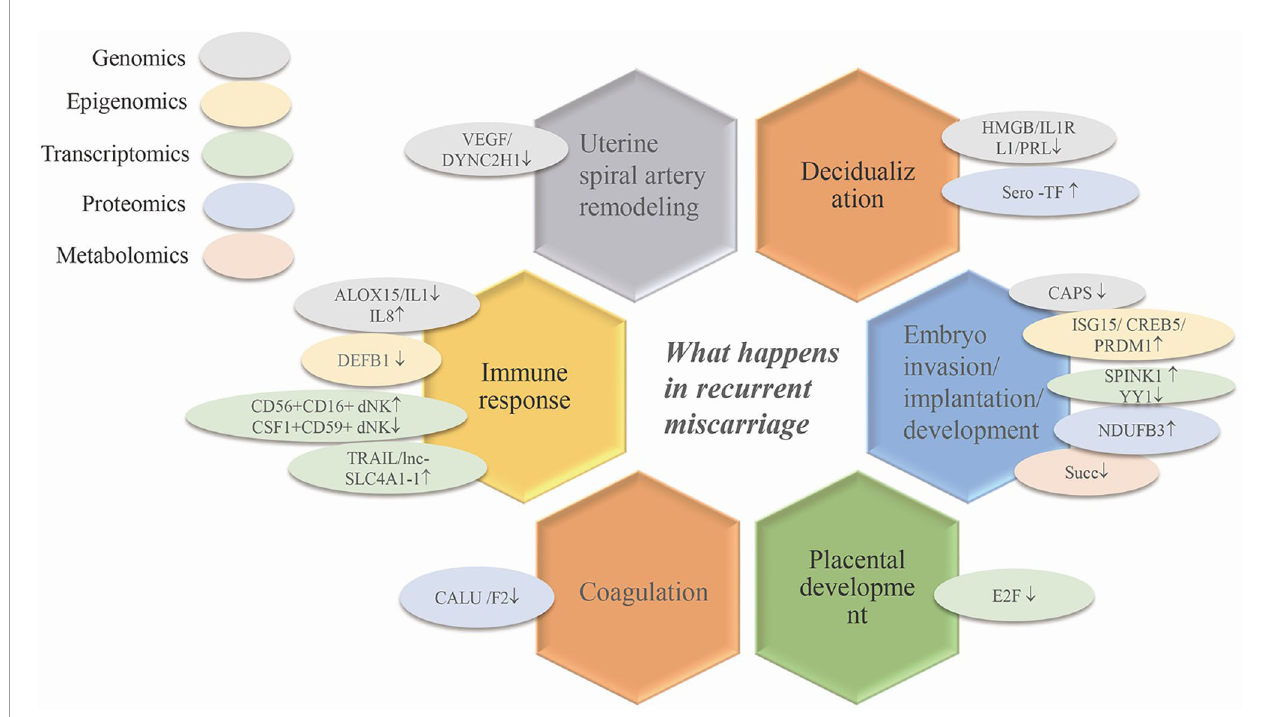
FIGURE 2 | The application of omics techniques in recurrent miscarriage. Ovals of different colors represent different omics studies. VEGF, vascular endothelial growth factor; HMGB, high mobility group box; IL1RL1, interleukin 1 receptor-like 1; PRL, prolactin; ISG15, interferon stimulated gene 15; SPINK1, serine peptidase inhibitor Kazal-type 1; CREB5, cAMP responsive element binding protein5; CAPS, calcyphsine; PRDM1, positive regulatory domain 1; YY1, yin and yang 1 transcription factor; NDUFB3, NADH dehydrogenase (ubiquinone) 1 beta subcomplex 3; E2F, one transcription factor family; IL1, interleukin 1; IL8, IL1, interleukin 1; CD56+CD16+dNK/CSF1+CD59+dNK, transcriptomics via single cell sequencing; TRAIL, TNF-related apoptosis-inducing ligand; lnc-SLC4A1-1, solute carrier family 4, anion exchanger, member 1; DEFB1, defensin beta 1; Succ, succinate; CALU, calumenin; F2, coagulation factor